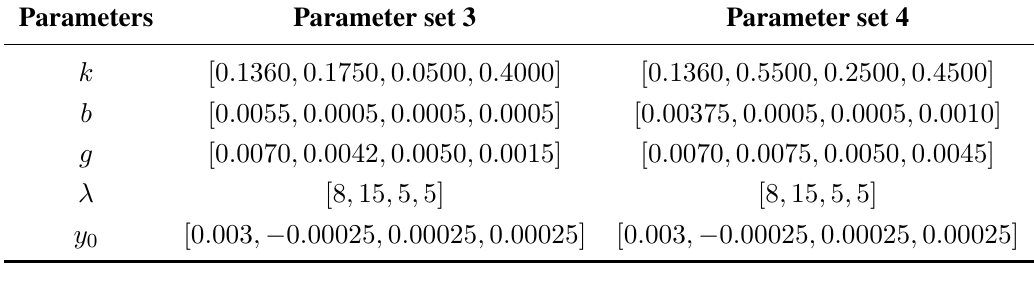
Table 3. Parameter sets used for sensitivity to the number of factors, N = 4 .